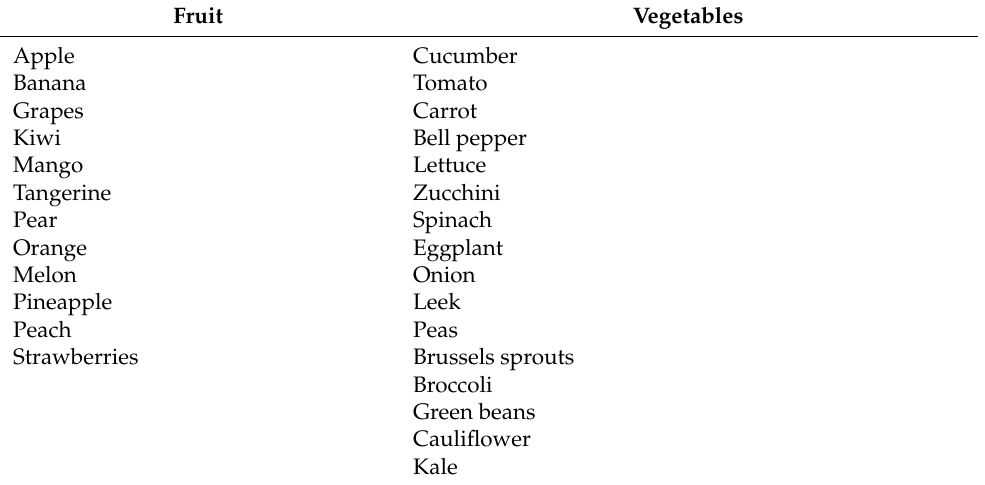
Table 2. Fruit and vegetable items assessed in the questionnaire. Fruit